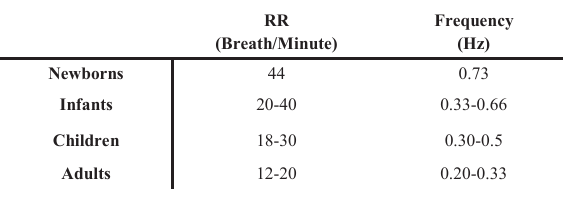
Table 2: Normal respiratory rates at different ages